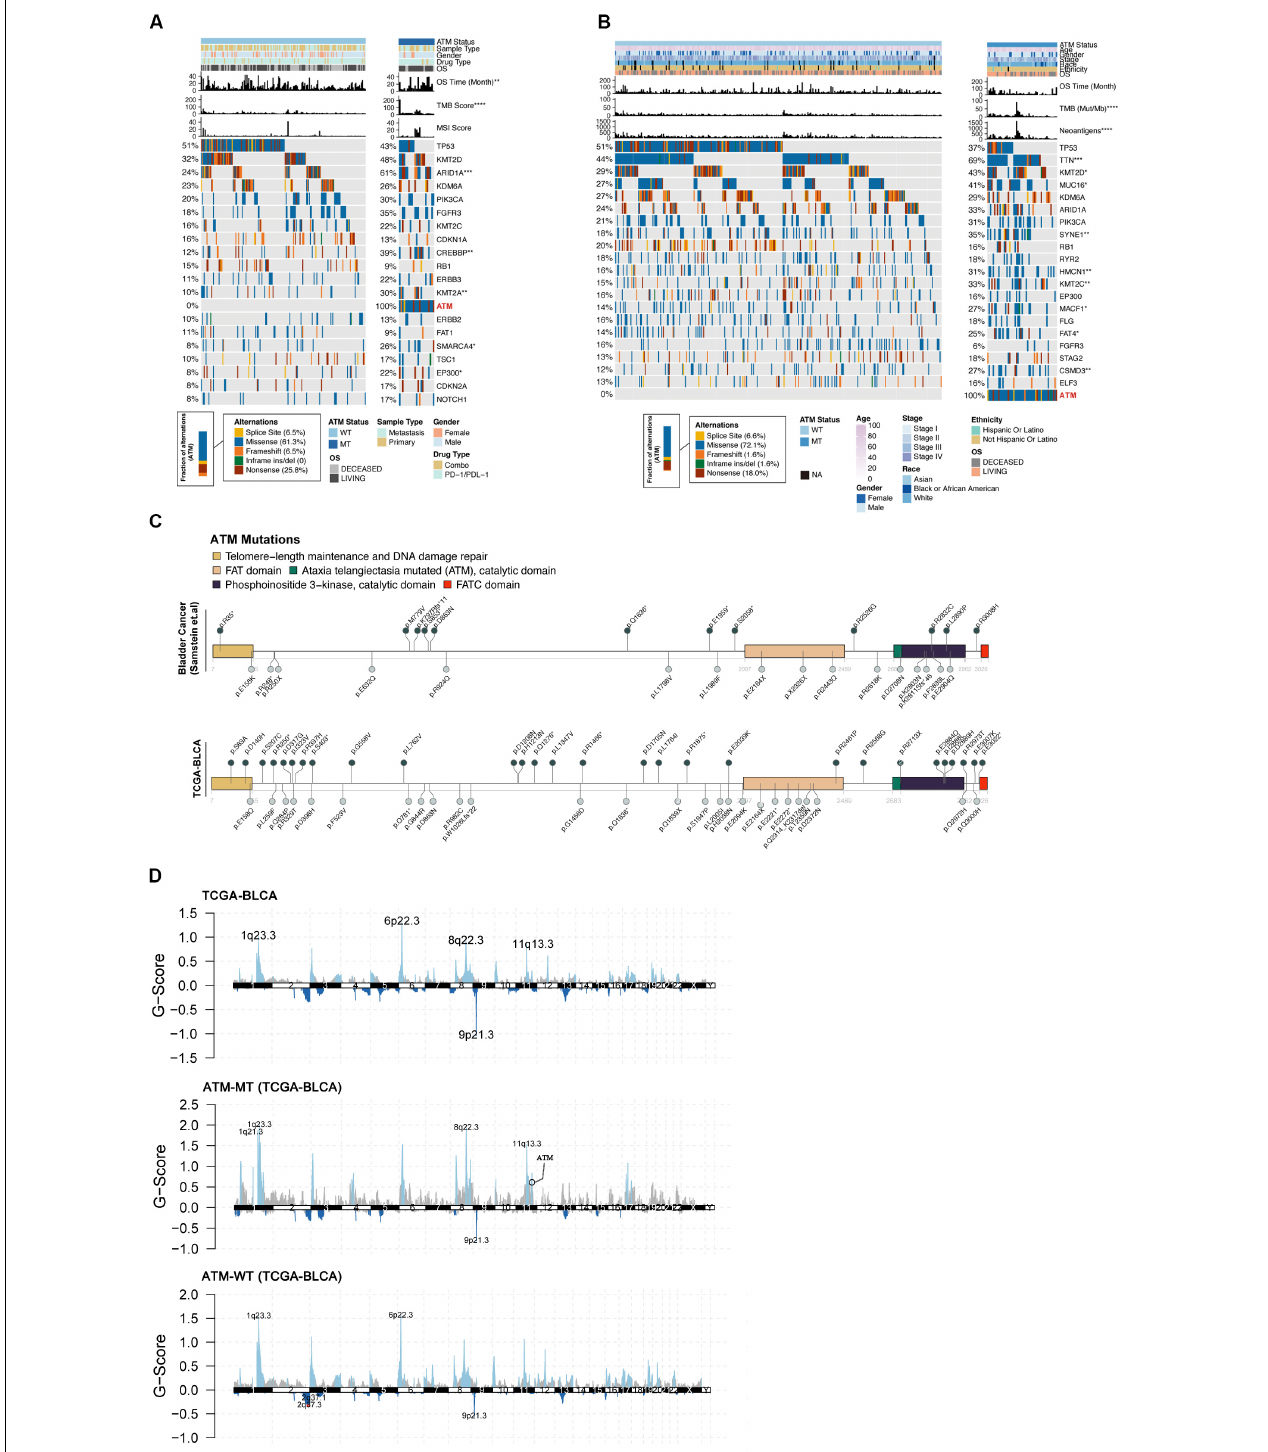
FIGURE 2 | Relationship between the ATM status and clinical phenotype. (A) Top 20 significantly mutated genes in the immunotherapy cohort of bladder cancer patients. Samples were ordered based on the somatic non-synonymous mutation burden, and genes were ranked by mutation frequencies (left panel). The ATM status, sample type (metastasis/primary), sex, drug type, OS, OS time (months), TMB score and MSI score are annotated in order in the top panel. (B) Top 20 significantly mutated genes in the TCGA-BLCA cohort. ATM status, age, sex, stage, ethnicity, OS, OS time (months), TMB and neoantigen load are annotated in order in the top panel. (C) The somatic mutations in ATM were evenly distributed in both the immunotherapy cohort and the TCGA-BLCA cohort. (D) Maftools was used to visualize the copy number alteration (CNV) analysis based on GISTIC2.0 of the TCGA-BLCA cohort.